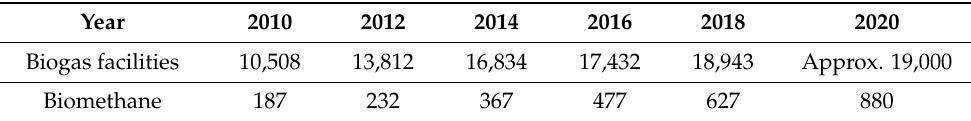
Table 7. Total number of biogas and biomethane facilities in the EU in the period 2010–2020 (according to